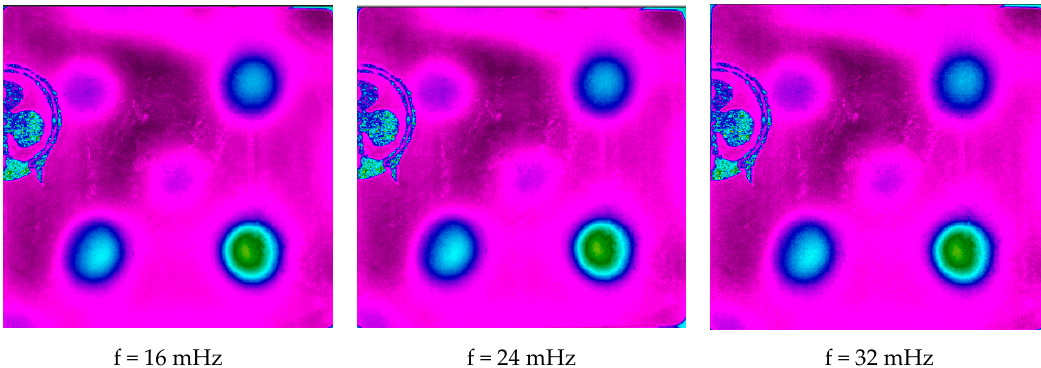
Figure 18. Amplitude images of the calculated harmonic response (at f = 16m Hz, f = 24 mHz and f = 32 mHz).